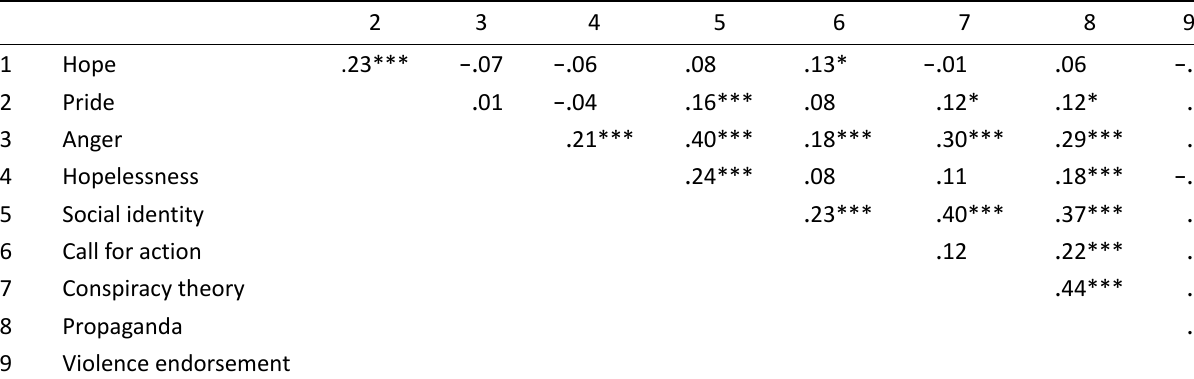
Table 3. Zero‐order